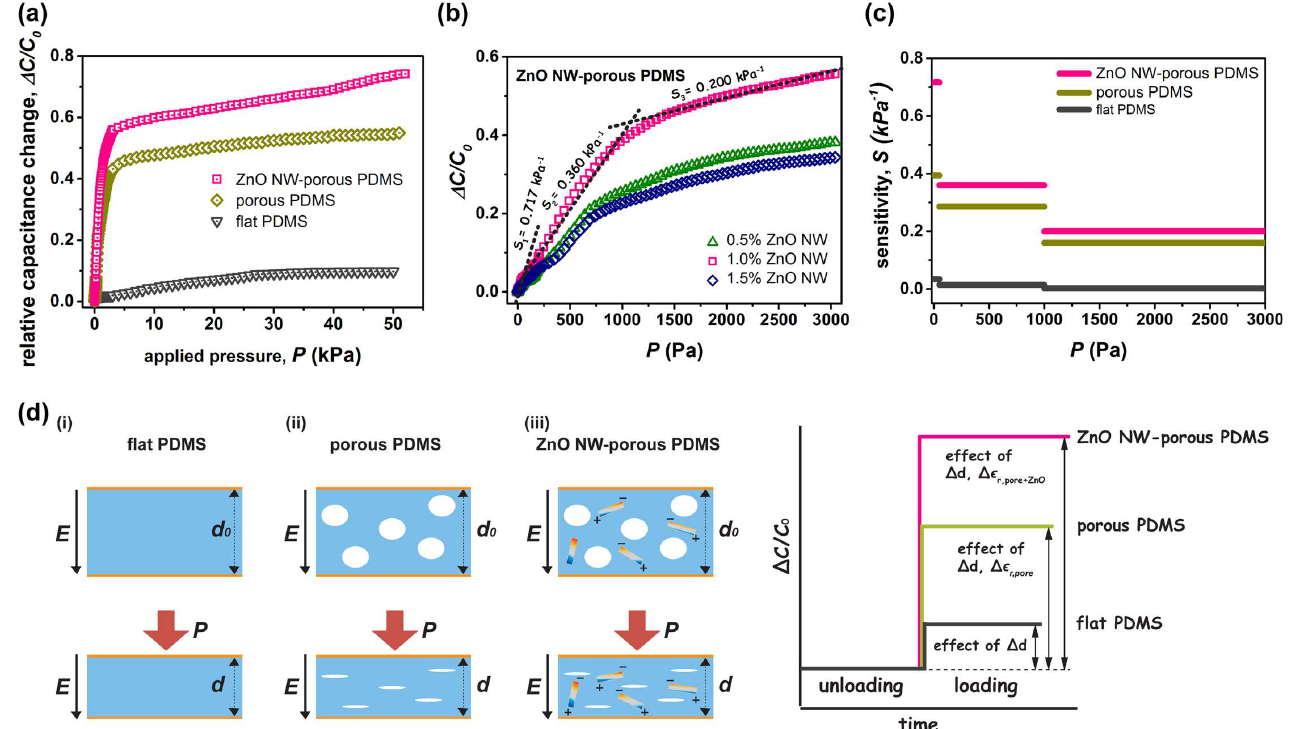
Figure 3. ( a ) Measured relative capacitance change (Δ C/C 0 ) as a function of the applied pressure ( P ) for the capacitive pressure sensors with different types of dielectric layers: flat PDMS, porous PDMS, and ZnO nanowire–porous PDMS (sensing area: 10 mm × 10 mm). ( b ) Pressure-response plots for these nanocomposite sensors with varying ZnO nanowire loading. ( c ) Comparison of the sensitivity of capacitive pressure sensors at different applied pressure ranges. ( d ) Proposed sensing mechanisms with graphical capacitance change for the capacitors containing (i) flat PDMS, (ii) porous PDMS, and (iii) ZnO nanowire–porous PDMS.